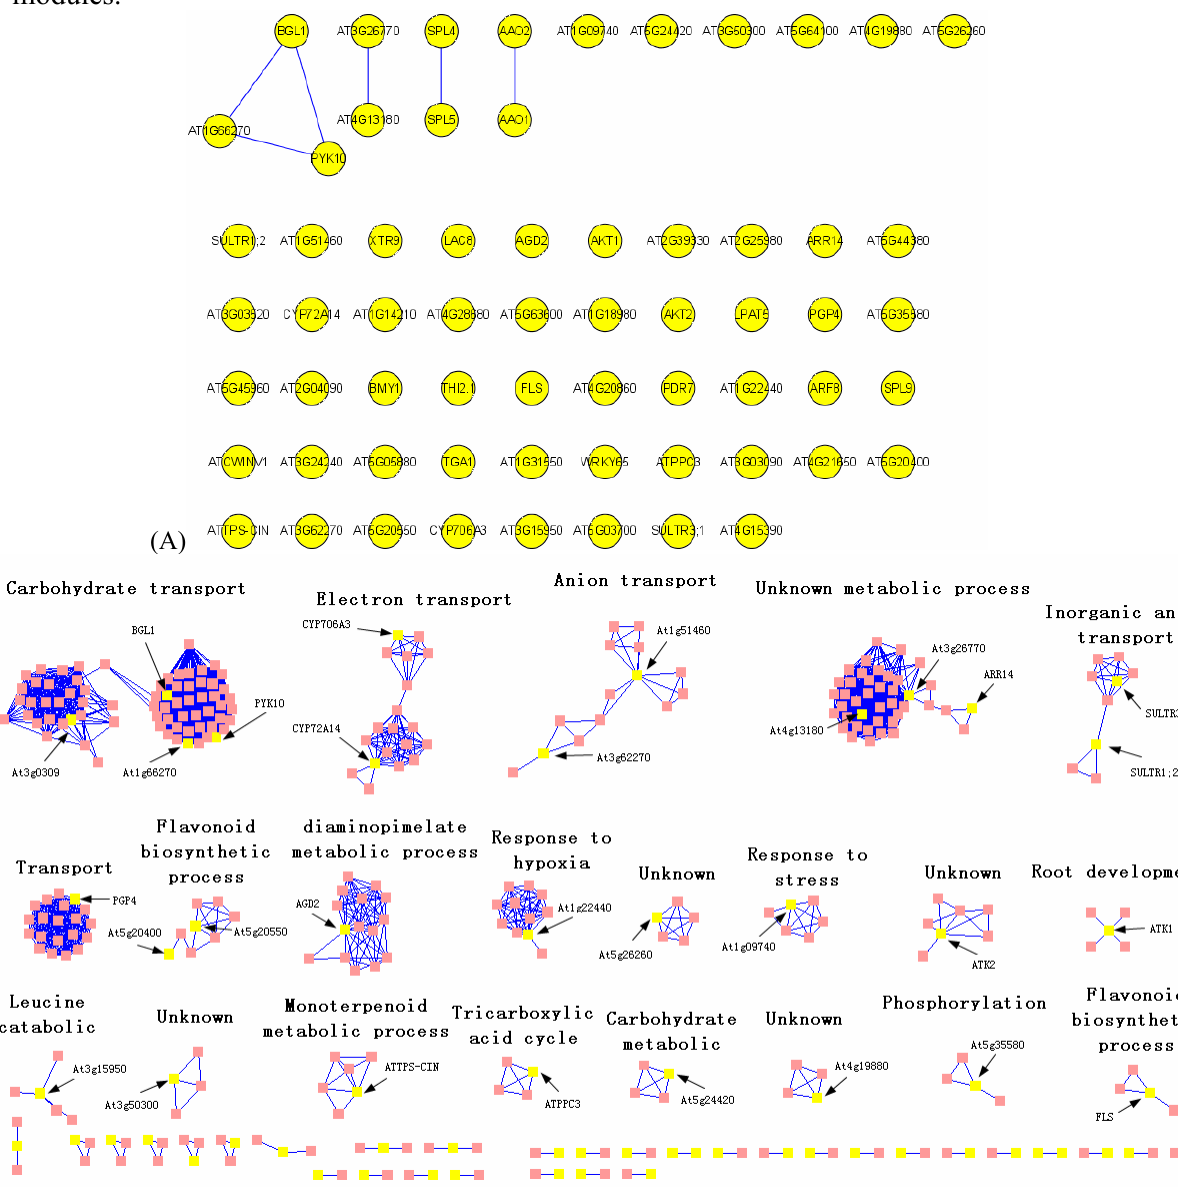
Figure 2. Network analysis of the Arabidopsis interactome showing direct interactions between co-expressed gene products and their first neighbors. (A) Direct interactions between correlated gene products. (B) Direct interactions between correlated gene products and their first neighbors. Some sub-networks show enrichment in GO terms (functional modules). Arrows indicate the SPL-correlated gene nodes present in these functional